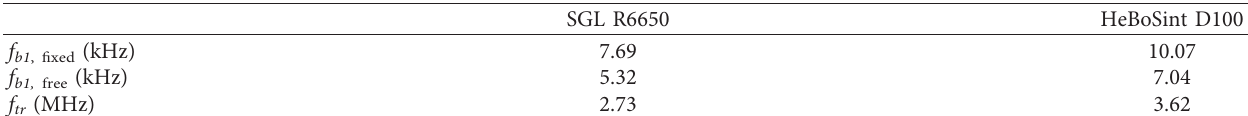
Table 3: Calculated first-order frequencies for bending and transversal elastic stress waves of isotropic graphite grade SIGRAFINE R6650 and h-BN grade HeBoSint D100. SGL R6650 HeBoSint